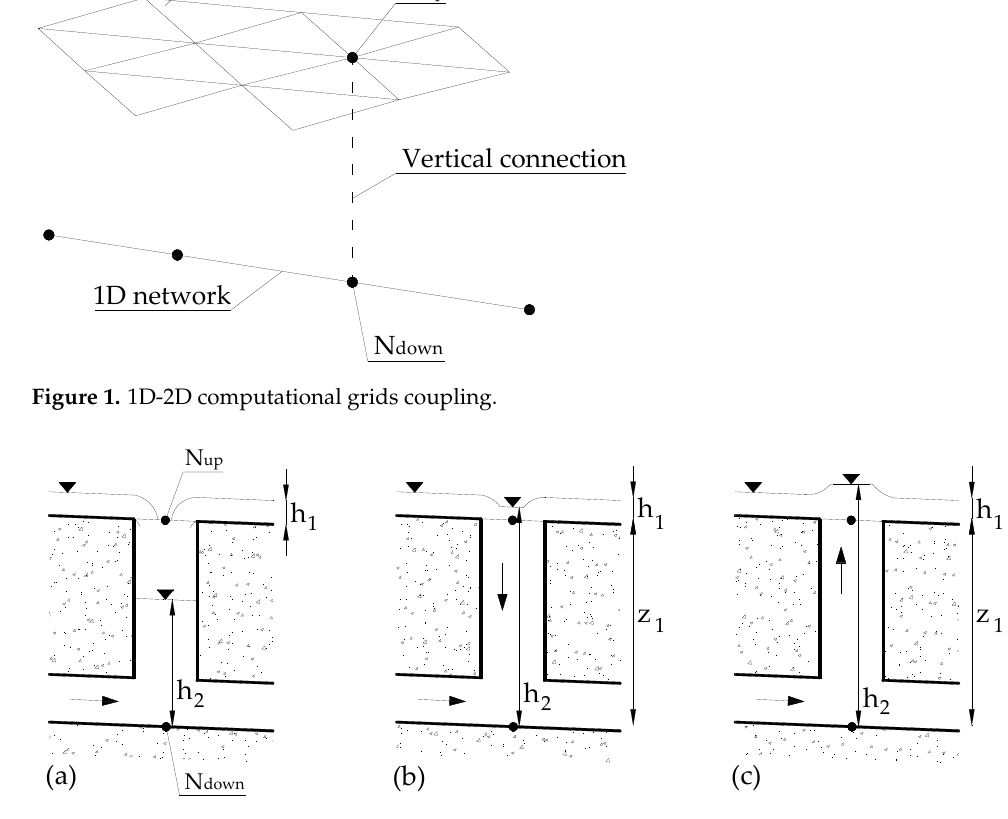
Figure 2. Water depths and possible flow configurations inside manholes: ( a ) Flow to the sewer pipe in case of not fully submerged manhole condition; ( b ) Flow to the sewer pipe in case of fully submerged manhole condition; ( c ) Flow from the sewer pipe in case of fully submerged manhole condition.